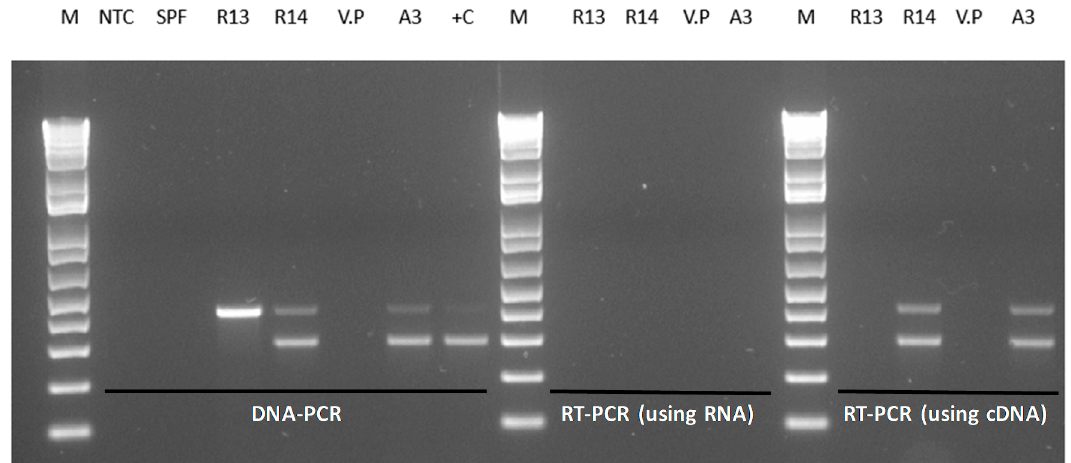
Figure 5. Polymerase chain reaction amplification of pir AB genes. Amplification of pir AB genes was performed using total genomic DNA (DNA-PCR), total RNA without synthesizing cDNA (using RNA) or after synthesis of cDNA (using cDNA). M = 1 kb molecular ladder, NTC = no template control in PCR, SPF = specific pathogen-free Penaeus vannamei, R13 = V. parahaemolyticus R13 strain,